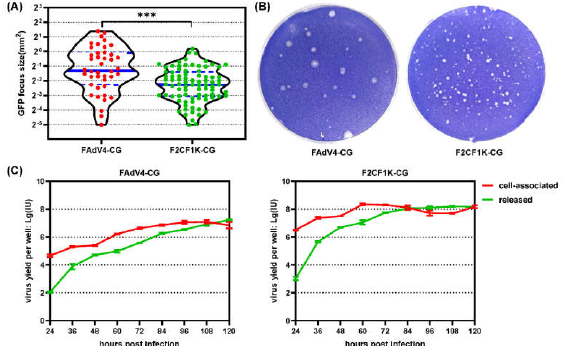
Figure 6. Growth of fiber-pseudotyped FAdV-4 vector in packaging LMH cells. Plaque-forming ex- periments were performed on chicken LMH cells. LMH cells in 6-well plates were infected with F2CF1K-CG or control FAdV4-CG at 10,000 vp/well for 2 h and maintained in semi-solid culture